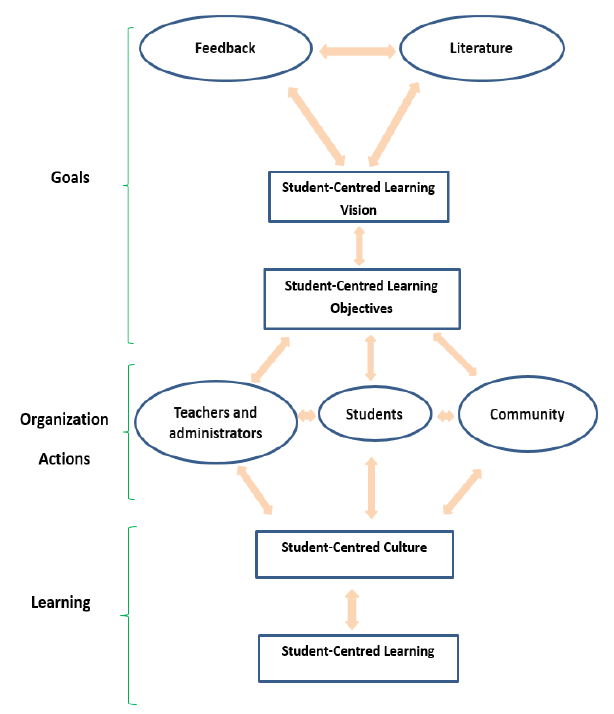
Figure 1. The reflexive GOAL framework at a higher education institution (HEI) level.